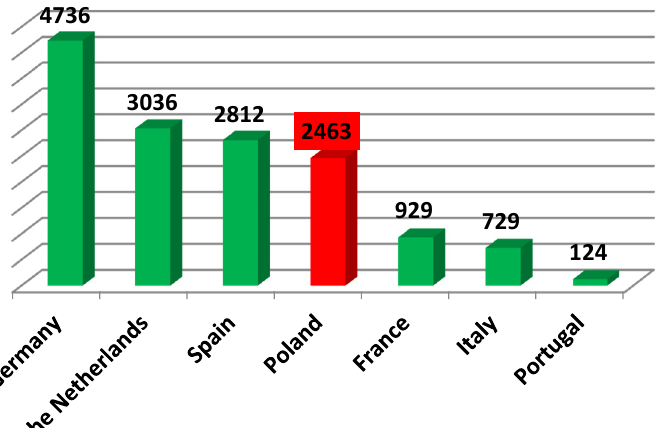
Figure 2. Growth of installed photovoltaic capacity in selected European Union countries in 2020, (data in MW). Source: own elaboration based on Energy Market Agency data [19].